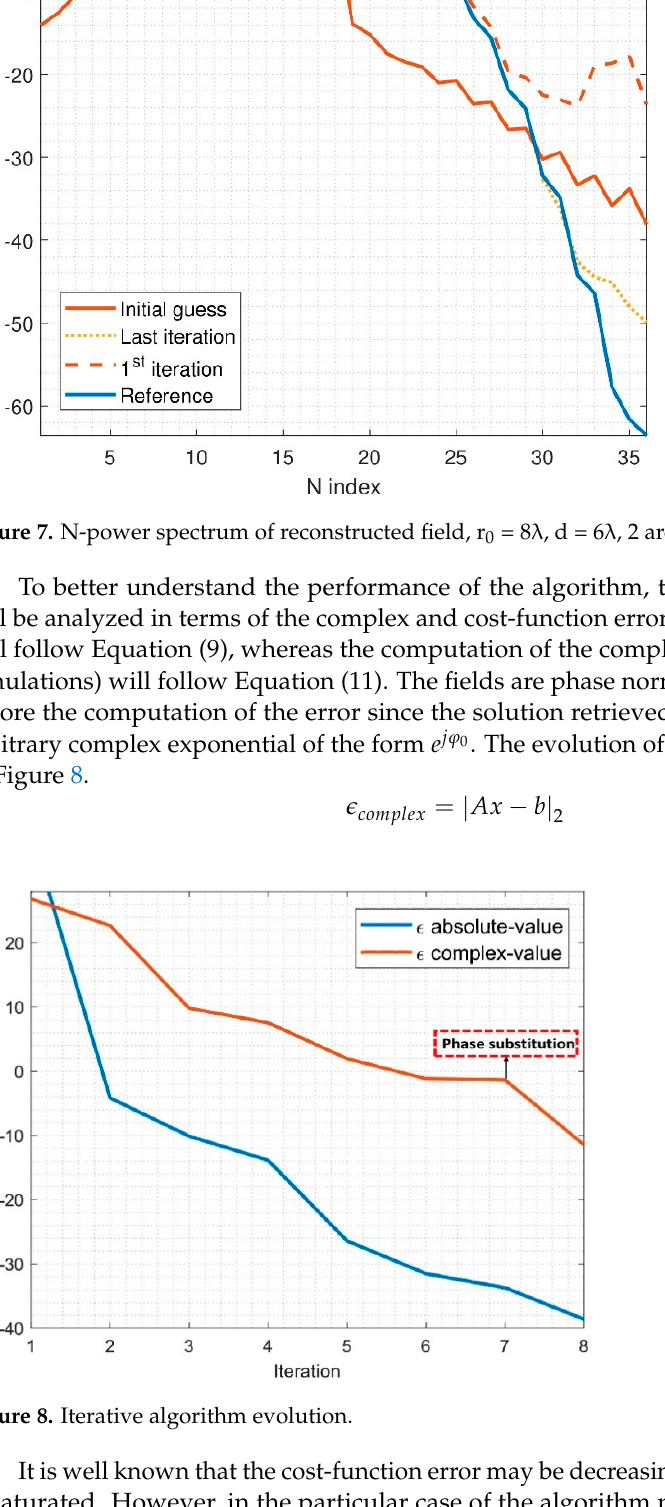
Figure 9. N ‐ power spectrum of reconstructed field, r 0 = 8 λ , d = 5 λ , 3 arch rotations.